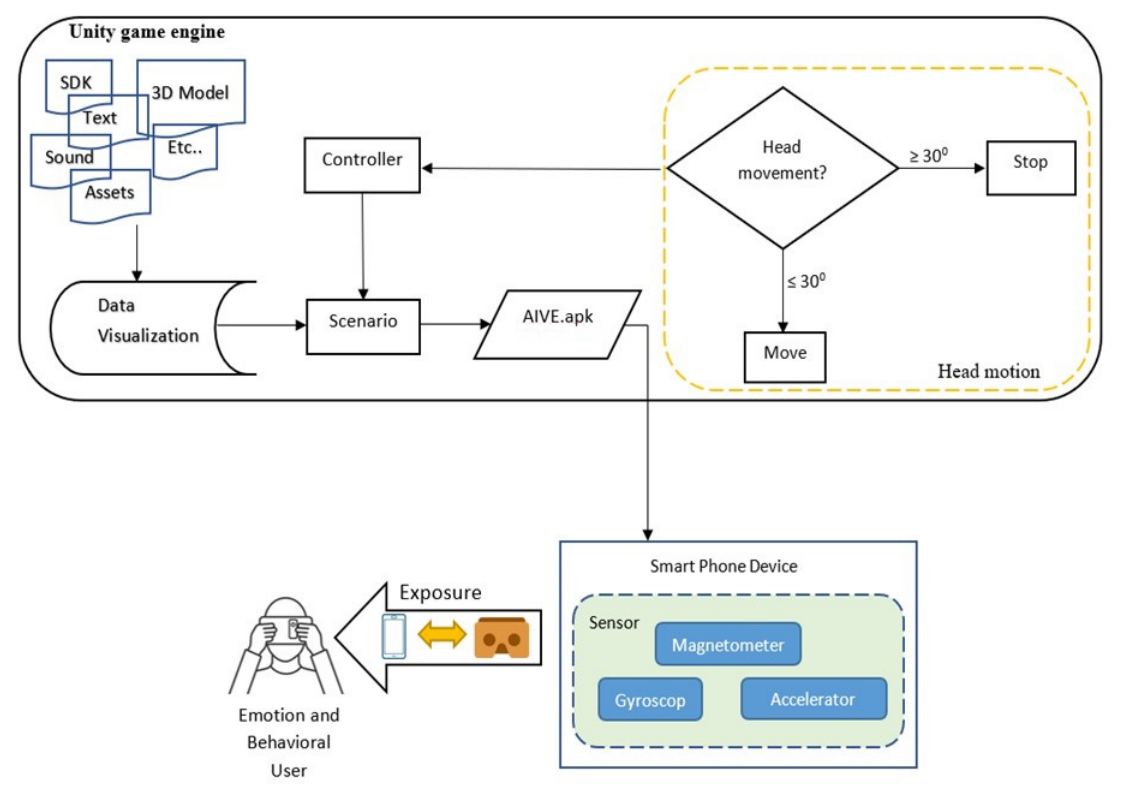
Figure 5. AIVE experimental